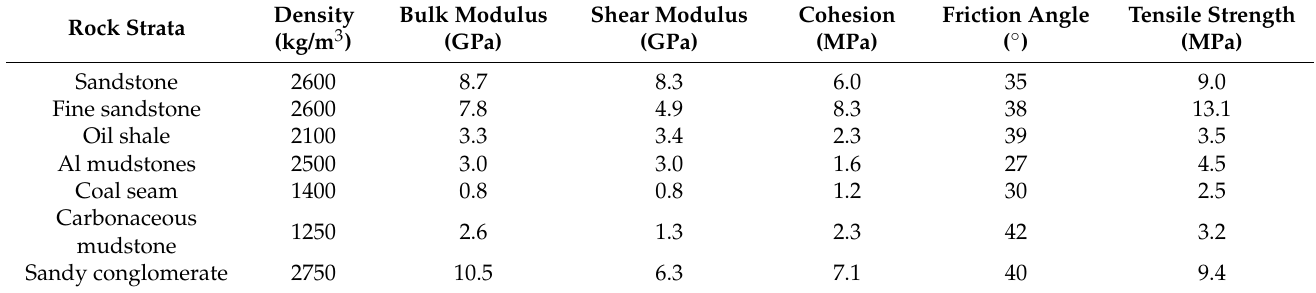
Table 2. Physical and mechanics properties of the rocks and coal joints.